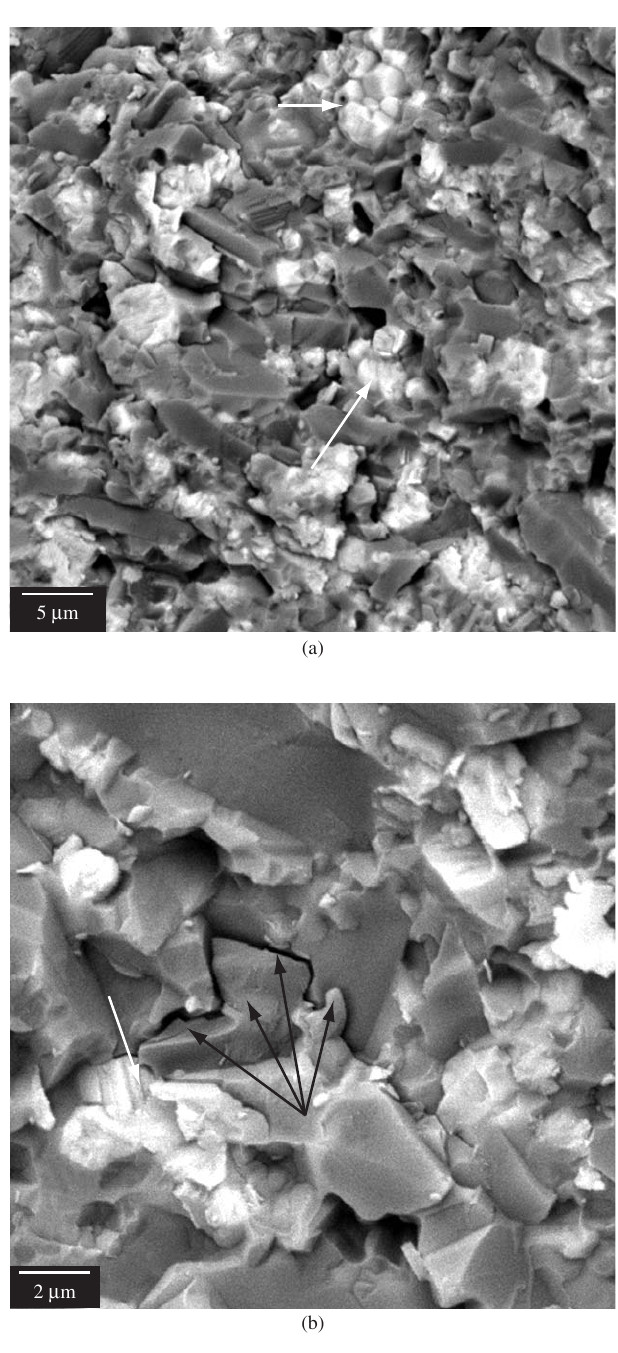
Figure 7. Scanning electron micrograph of an infiltrated ZTA fractured sample. Note small zirconia agglomerates (white arrows) dispersed among alumina grains and a crack contouring an alumina grain (black arrows), being held by one of these